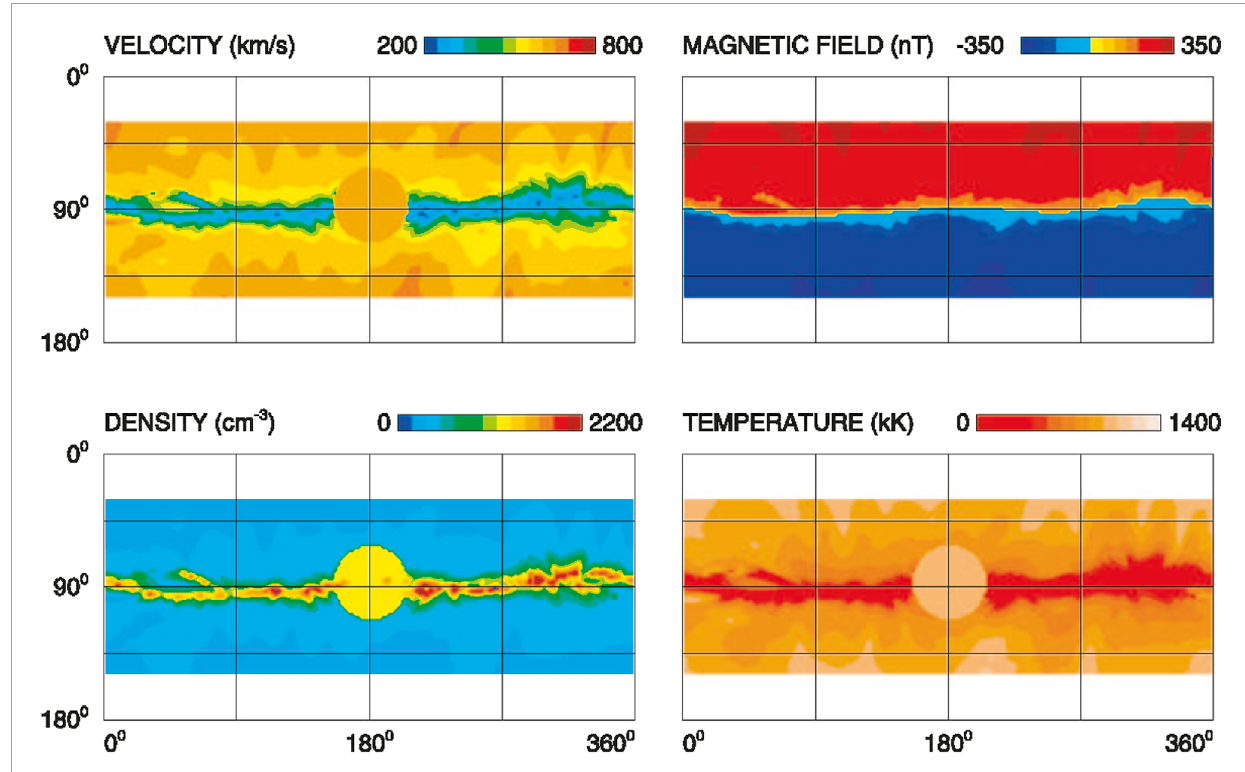
FIGURE 10 Distribution of solar wind parameters with the introduction of the input pulse on 12 May 1997 at 1800 UT (Odstrcil, 2005).